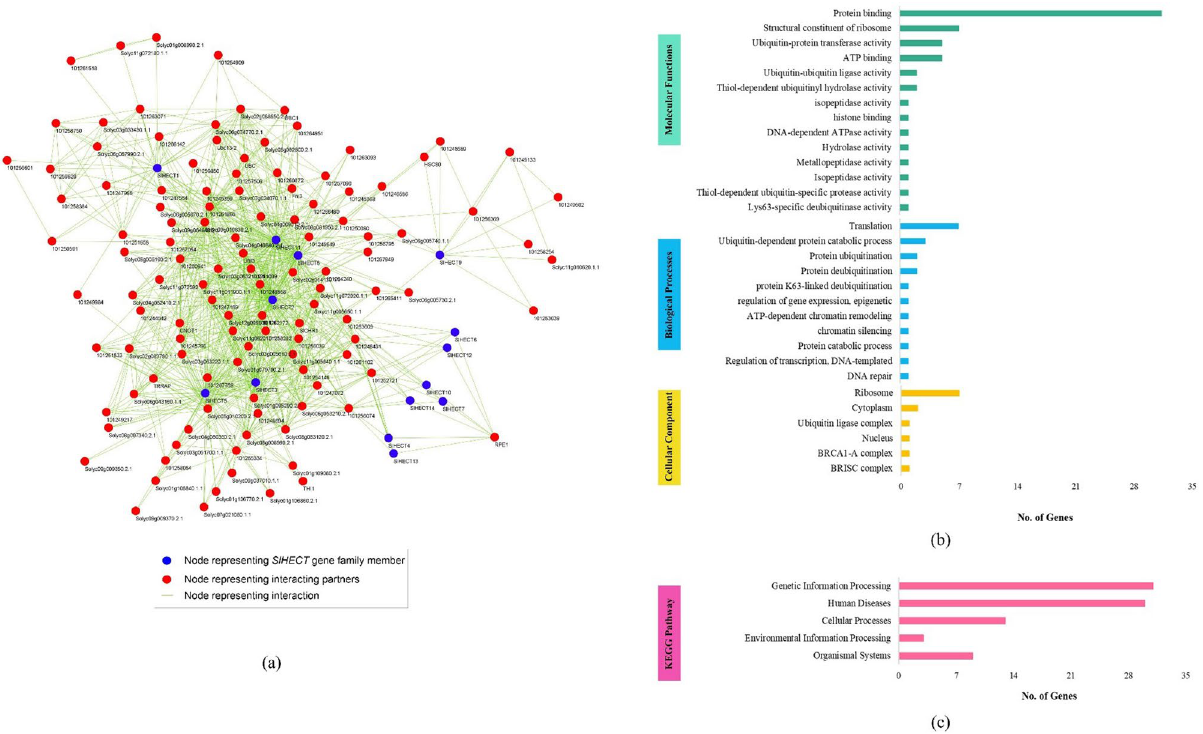
Figure 6. ( a ) Protein–protein interaction (PPI) network of tomato HECT E3 ubiquitin gene family. Blue nodes denote SlHECT members, red nodes represent interacting partners and green edges show an interaction between the nodes ( b ) gene ontology analyzed using Blast2GO suite ( c ) pathway analysis of tomato HECT E3 ligases and their interacting partners using the KAAS